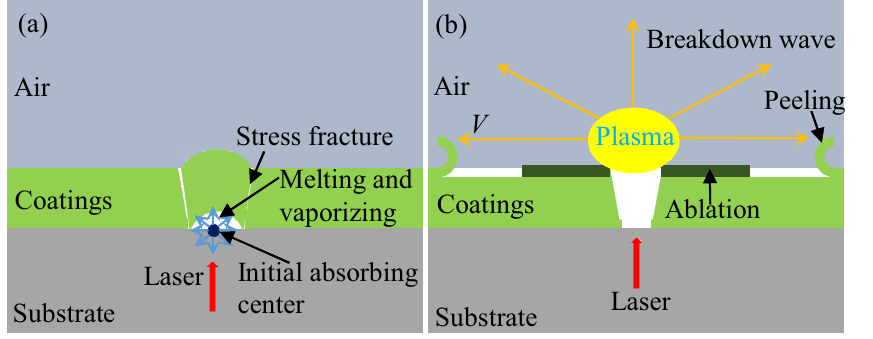
Figure 6. Schematic diagram of laser damage process: ( a ) initial defect absorbing laser energy, thermomechanical coupling effect; ( b ) ionizing air to form plasma, peeling off